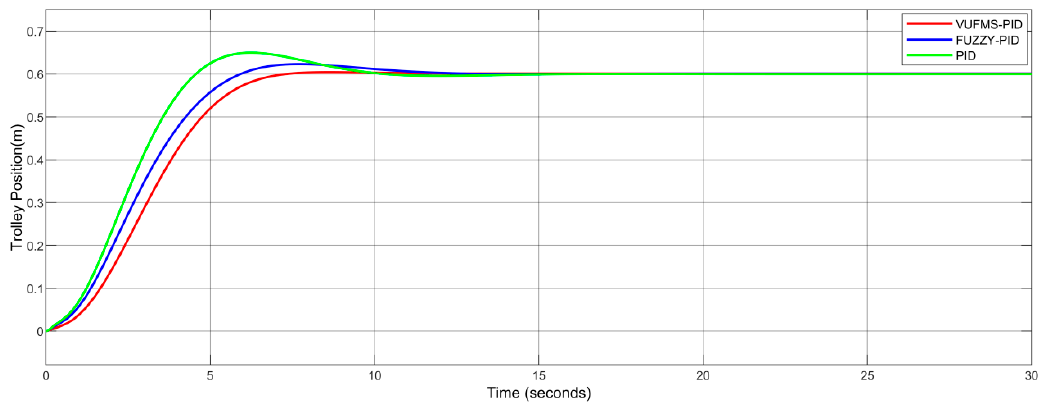
Figure 11. Payload’s swing angle ( θ ) using VUFMS-PID, FUZZY-PID and PID controller under working condition 2.